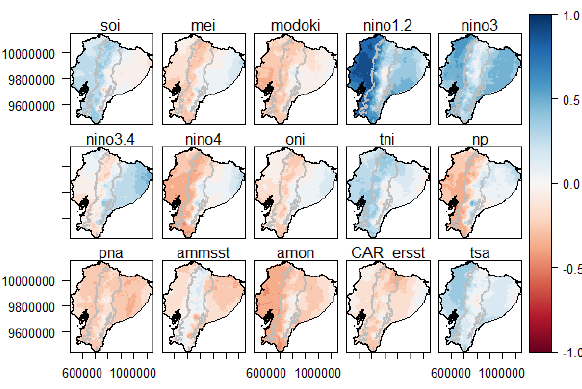
Figure 2. Correlation maps of climate teleconnection from Pacific and Atlantic climate